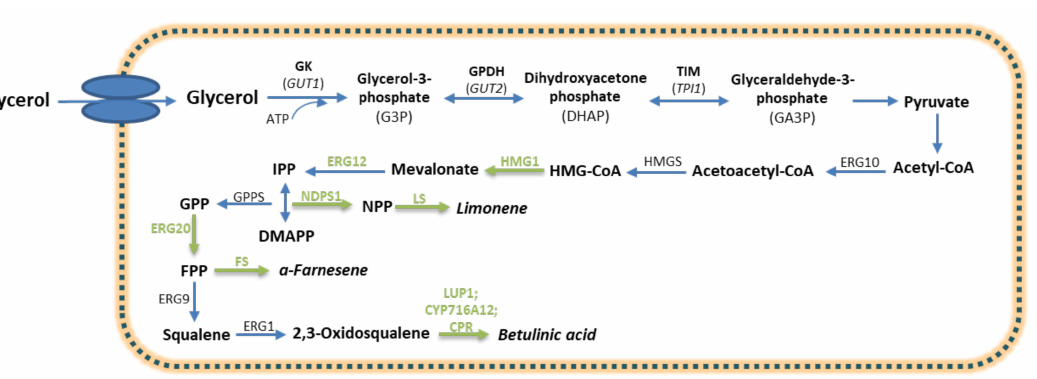
Figure 3. Terpenoids biosynthesis in Y. lipolytica. Enzyme abbreviations are: ERG10, acetyl-CoA C-acetyltransferase; HMGS, hydroxymethylglutaryl-CoA synthase; HMG1, HMG-CoA reductase; ERG12, mevalonate kinase; GPPS, geranyl diphosphate synthase; NDPS1, neryl diphosphate synthase 1; LS, limonene synthase; ERG20, farnesyl diphosphate synthase; FS, farnesene synthase; ERG9, squalene synthase; ERG1, squalene monooxygenase; LUP1, lupeol synthase; CYP716A12, cytochrome P450 monooxygenase; CPR, cytochrome P450 reductase. Abbreviations of metabolites are: HMG-CoA, 3-Hydroxy-3-methylglutaryl-coenzyme A; IPP, isopentenyl pyrophosphate; DMAPP, dimethylallyl pyrophosphate; GPP, geranyl diphosphate; NPP, neryl diphosphate; FPP, farnesyl diphosphate. Green arrows indicate gene overexpression as discussed in this